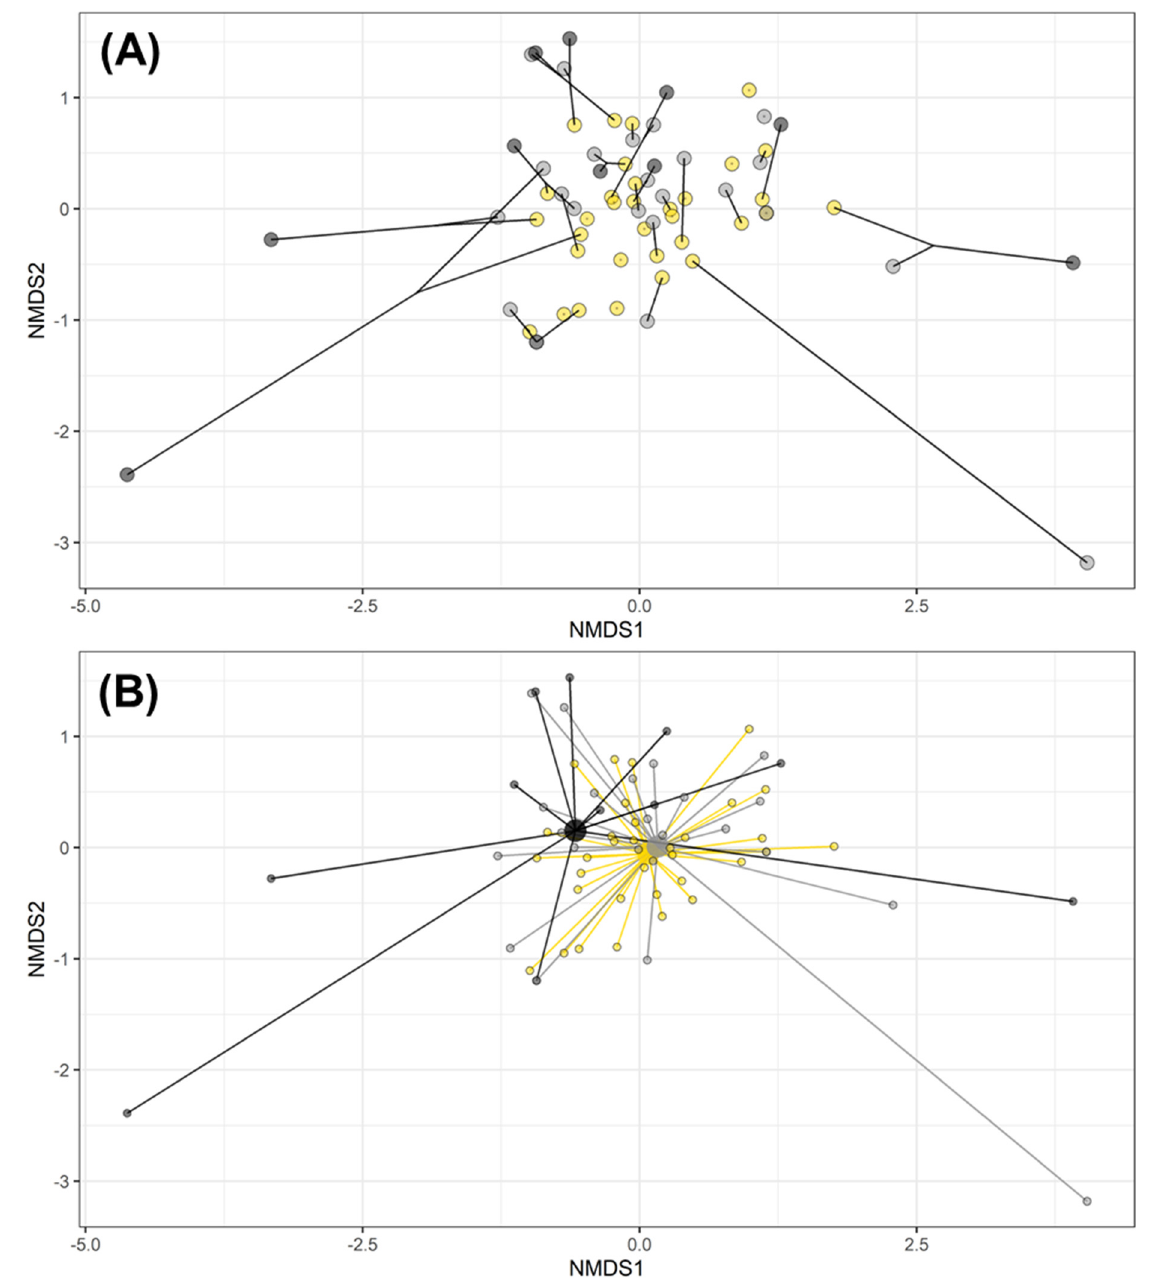
Figure 5. Spider plots of assemblages by cave zone derived from non-metric multidimensional scaling. Colours denote cave zones (black, grey, and yellow denoting dark, twilight, and entrance zones, respectively). Axes represent a two-dimensional variation in spider assemblages. Each smaller point in both images represents a single assemblage present in a specific cave and a specific zone, with the distance between them indicating their dissimilarity (i.e., proximate points are similar, distant points are dissimilar). Average species coordinates are overlaid in Figure S1. Stress = 0.1002019. ( A ) Points are joined by the centroids of assemblages in each group (larger points = mean coordinates in that group); a high degree of overlap is observable, particularly between twilight and entrance assemblages, but dark zone assemblages are more distinct and highly variable. ( B ) Joined points belong to the same cave; these are typically more similar (i.e., points are closer) than those of other caves, with the exception of many of the dark zone assemblages (generally around the outside of the central cluster of points), which show substantial variation.